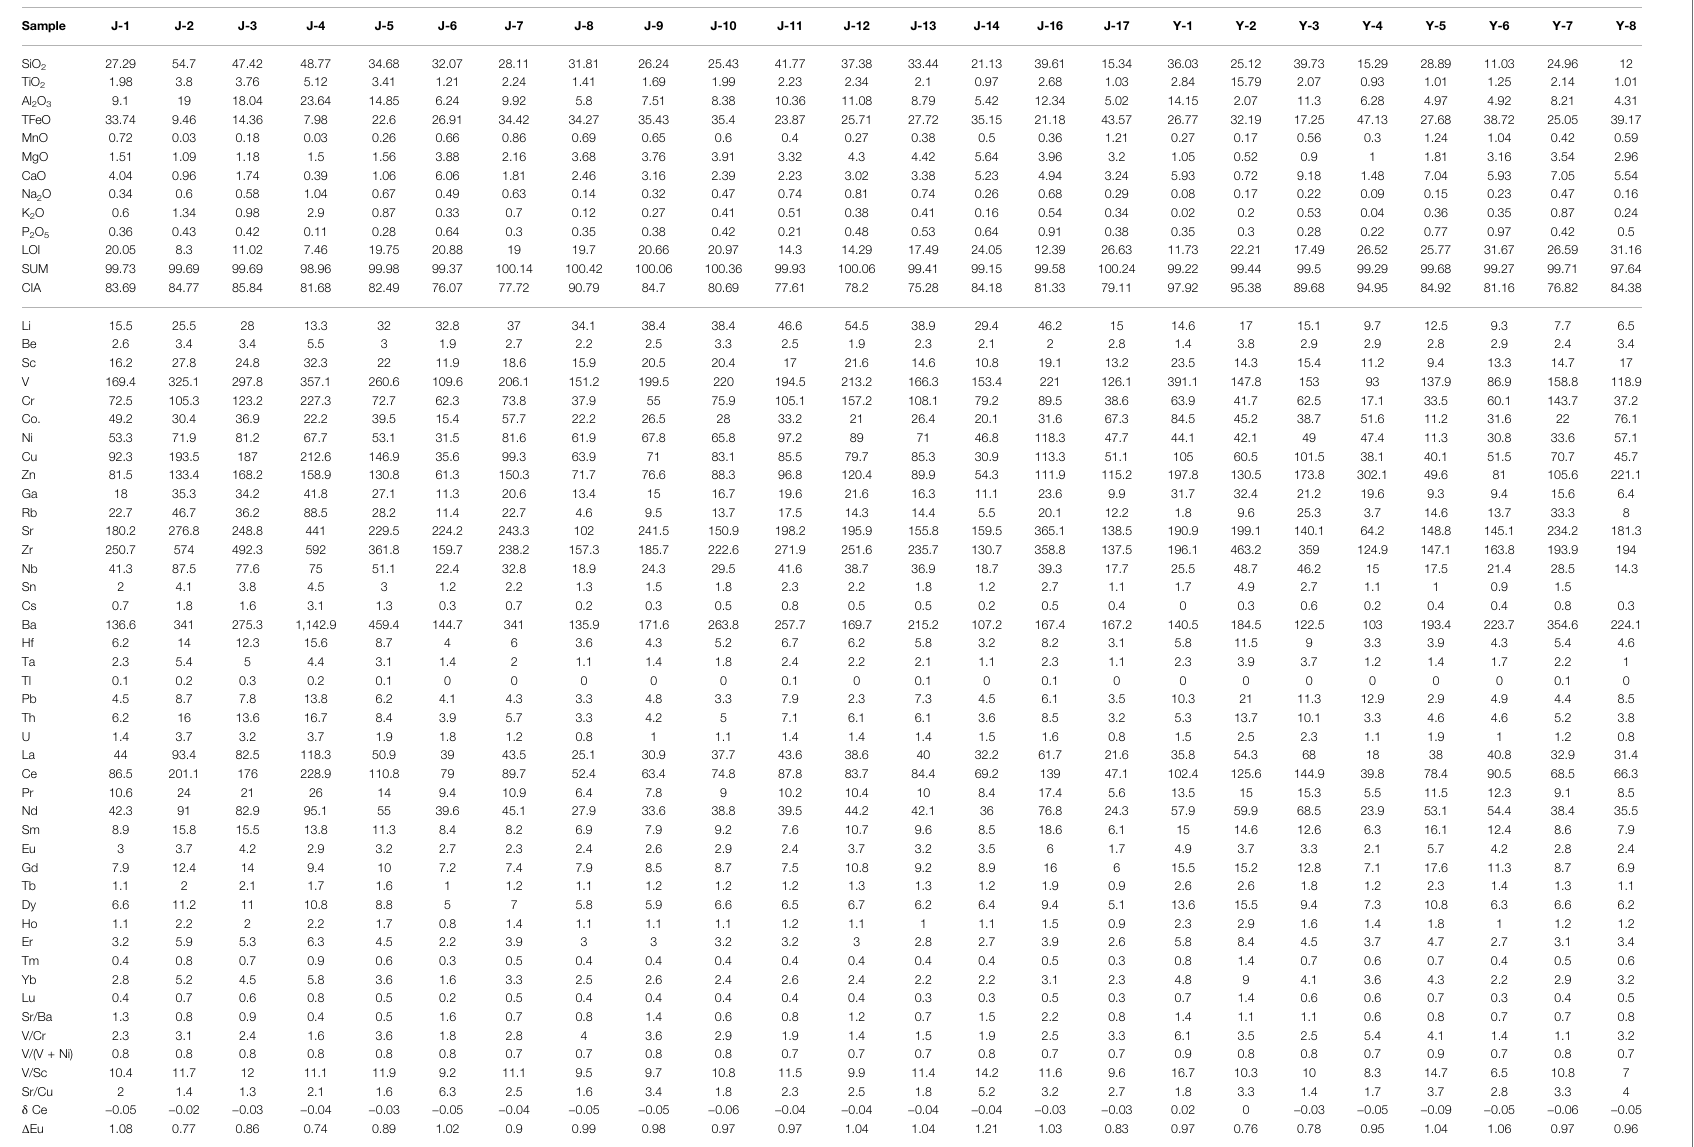
TABLE 2 | Statistics of major element oxide content (wt%), trace element, and rare earth element concentrations ( μ g/g) of the studied samples.